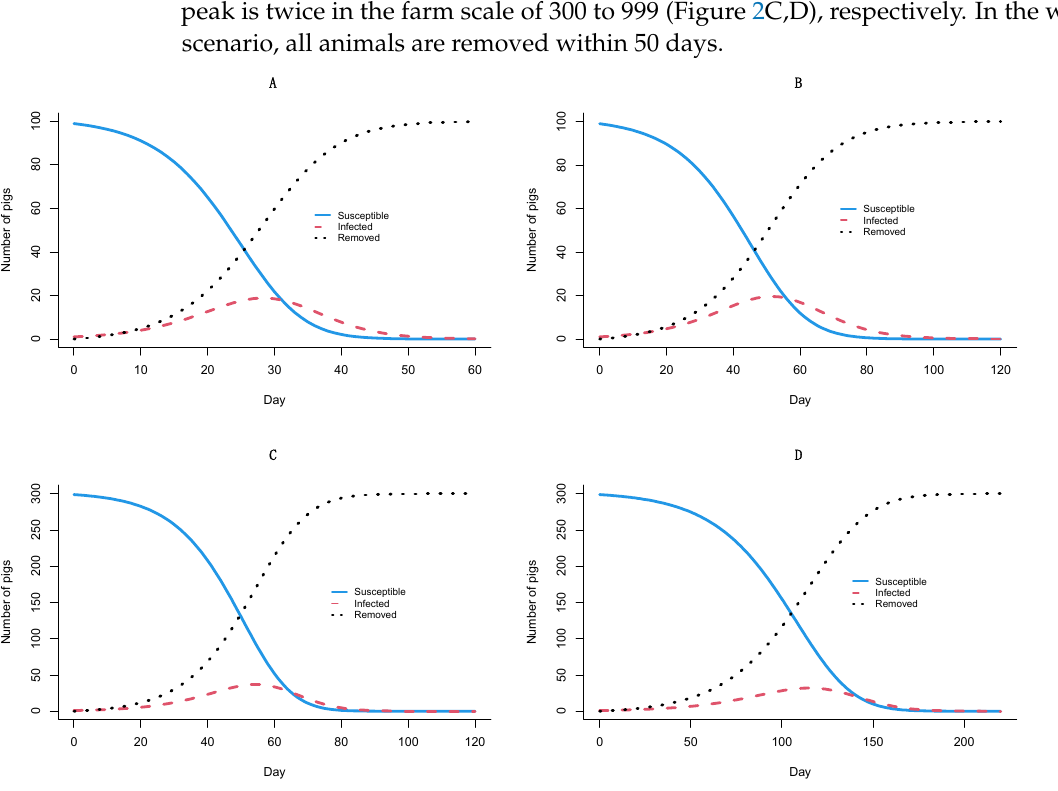
Figure 2. SIR models of ASF transmission within-farm. Models 1 ( T = 3–6 days) and 2 ( T = 3–14 days) with the range of infectious period of the farm scale 100 to 299 animals ( A , B ) and models 3 ( T = 3–6 days) and 4 ( T = 3–14 days) with the range of infectious period of farm scale 300 to 999 animals ( C , D ), respectively.